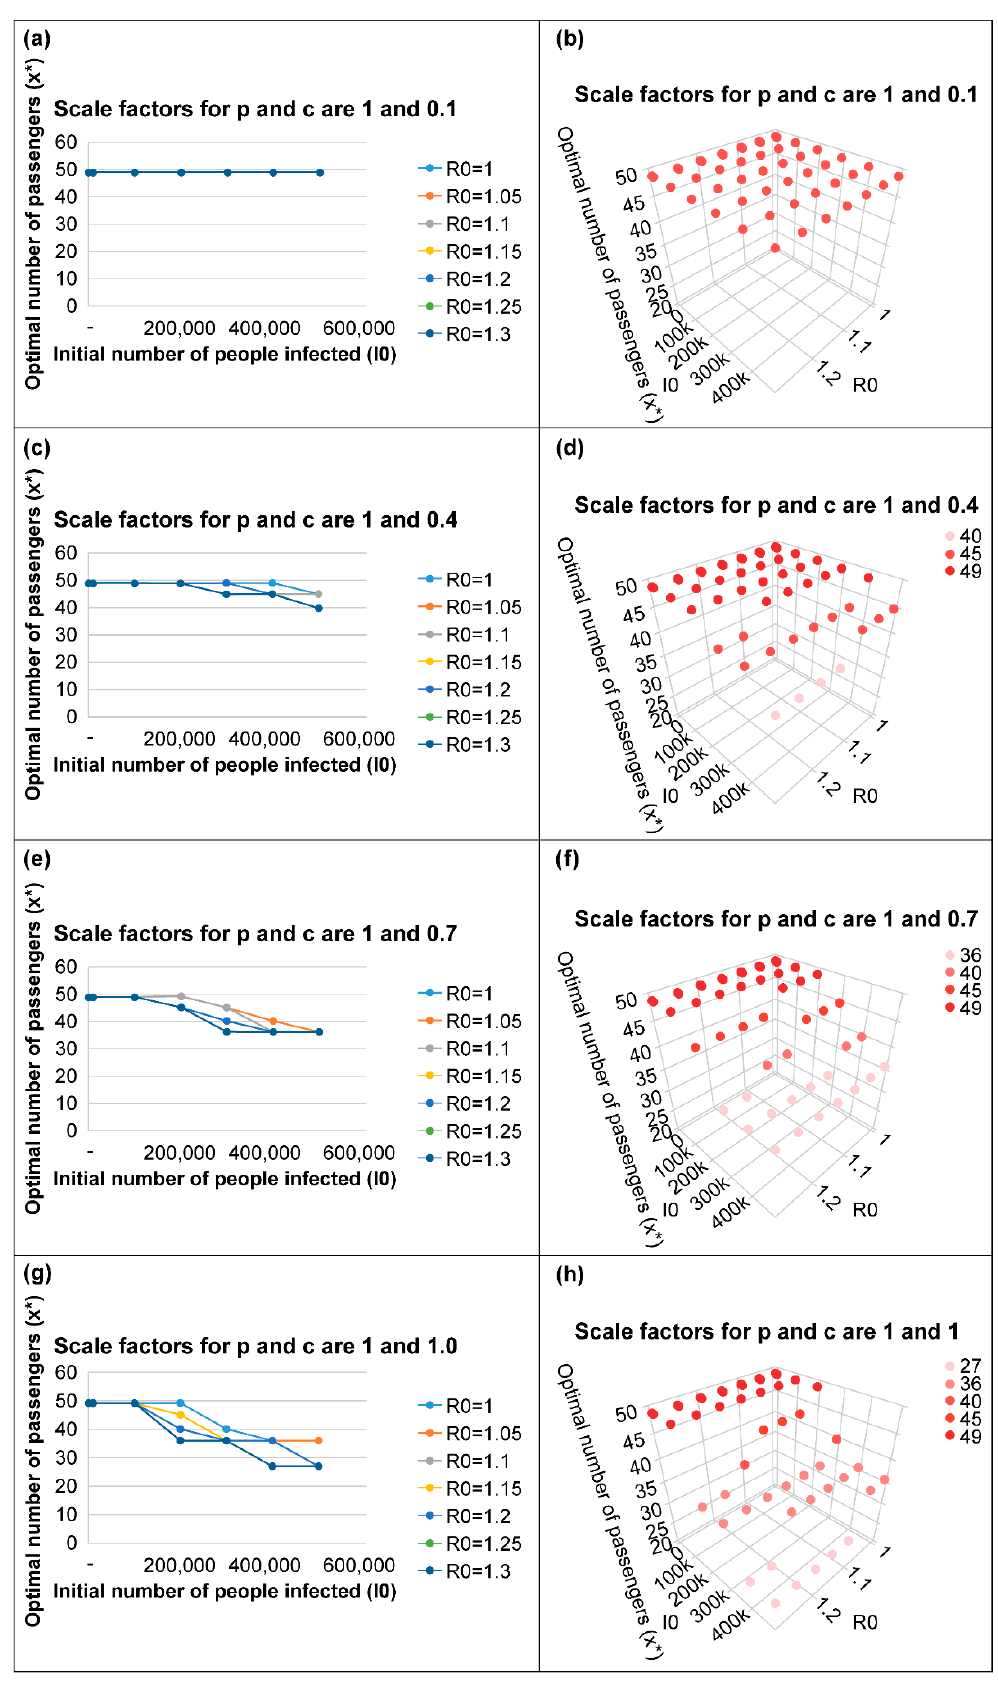
Figure 2. Optimal number of passengers to minimize total social cost when the scale factor for p is 1.